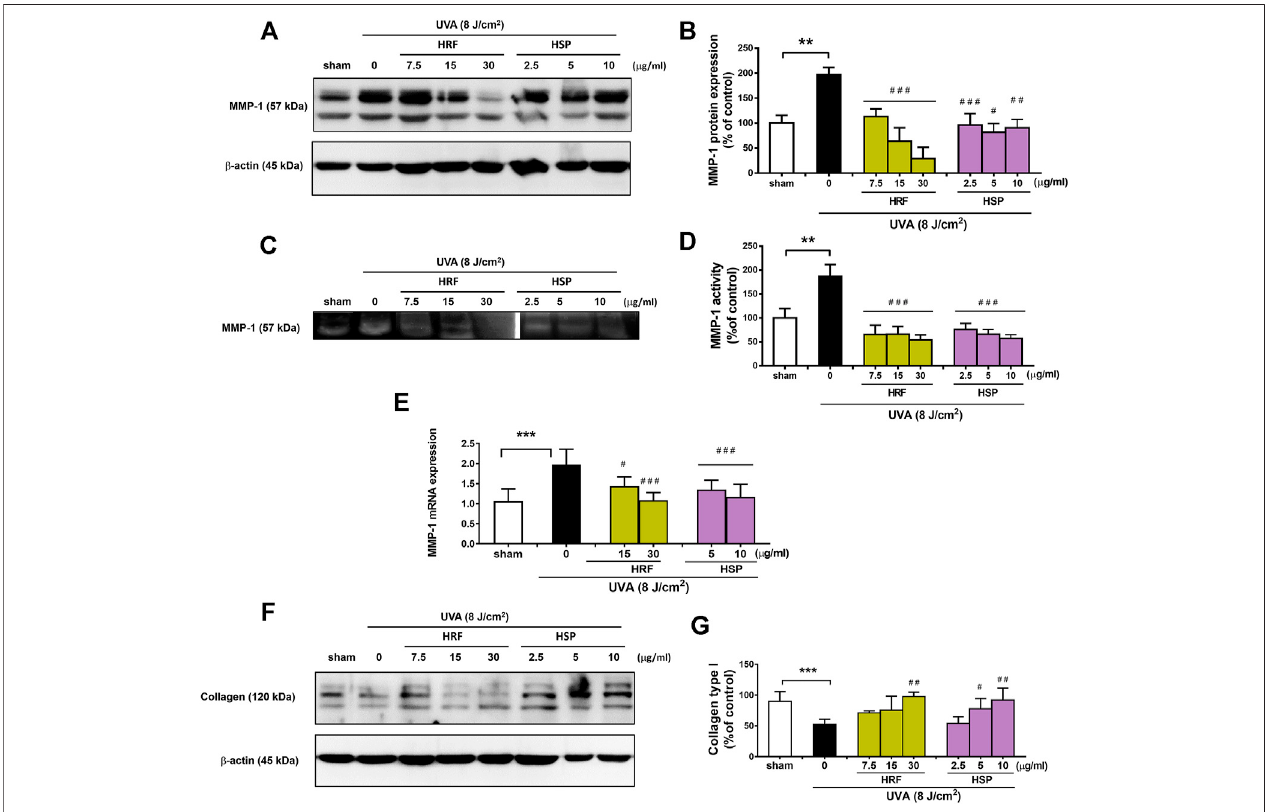
FIGURE2 | The protective effects ofHRFand its active ingredient onthe photodamaged skin viathe alteration of MMP-1 and collagen levels. NHDFs weretreated withcompoundsaspreviouslydescribedandharvestedat24 hfollowingUVA(8 J/cm 2 )exposureforthewesternblotanalysisoftheMMP-1proteinexpressionwiththe indicated molecular weight (57 kDa), MMP-1 enzyme activity by zymography, mRNA levels of MMP-1 and western blot analysis of collagen type 1 (% of control). The representative blot pictures of (A) and summary graph analysis of MMP-1 protein expression (B) . The collagen zymography (C) and summary graph analysis of MMP-1 enzymeactivity (D) and the mRNA levels ofMMP-1 (E) . The collagen type Iwith theindicatedmolecularweight(120 kDa) (F) and summary graph analysis (G) in each compound treatment as compared to ethanol treatment. ** p < 0.01 and *** p < 0.001 vs. non-irradiated sham group by Student ’ s t -test. #p < 0.05; ## p < 0.01; ### p < 0.001 vs. the sham-irradiated group by one-way ANOVA Dunnett ’ s